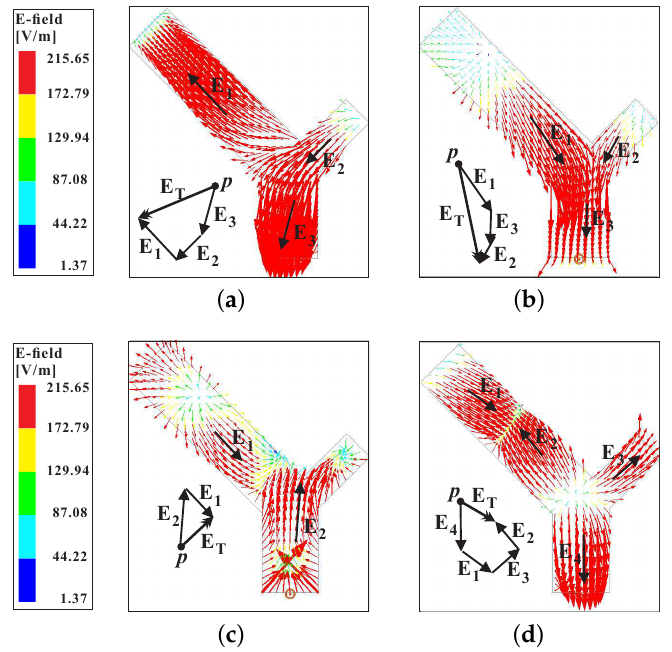
Figure 3. Simulated E-field on the top surface of the proposed Y-shaped DR within the CP bands: ( a ) 46 GHz at t = 0; ( b ) 2.46 GHz at t = T /4; ( c ) 3.5 GHz at t = 0; ( d ) 3.5 GHz at t = T /4.